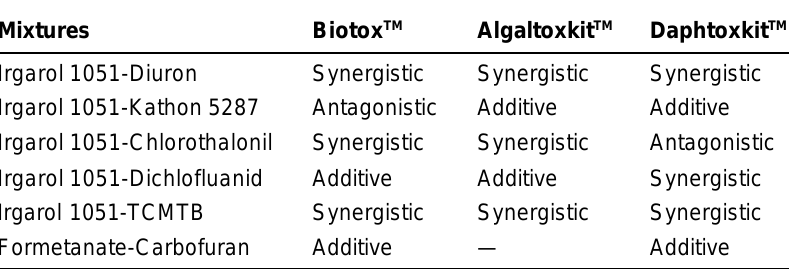
Synergistic Effects for Binary Mixtures of